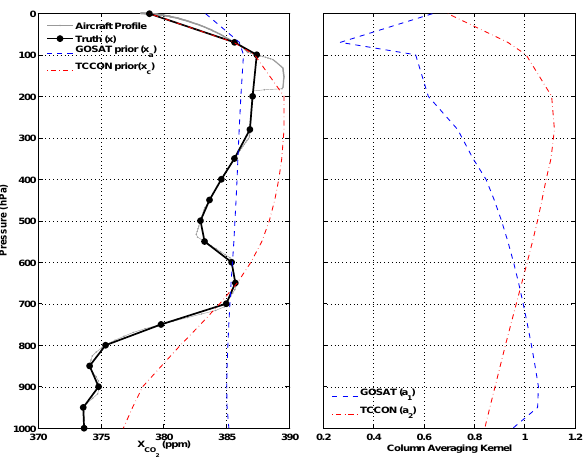
Fig. A3. Plots from 2 August 2009, when there was an overflight of Lamont that spanned a large altitude range (0–12km). The left panel shows the aircraft profile (grey) which uses the TCCON a priori profile to fill in the stratosphere above the aircraft ceiling, the true profile (black; i.e., the aircraft profile interpolated onto the ACOS retrieval grid), the ACOS-GOSAT a priori profile (blue) and the TCCON a priori profile (red). The right panel shows the ACOS- GOSAT (blue) and TCCON (red) column averaging kernels for the time of the aircraft